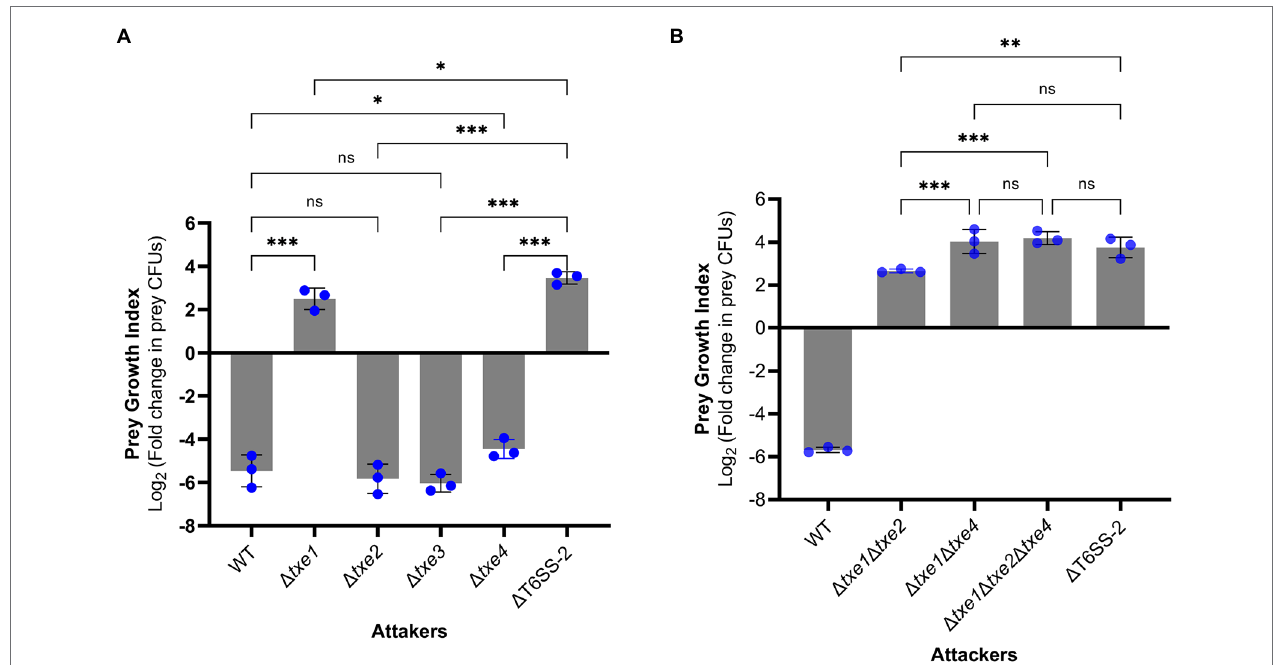
FIGURE 6 | Interbacterial competition assay with P. plecoglossicida wild-type (WT) and deletion mutants as attackers. The prey growth index (PGI) was calculated from the prey strain E. coli XL10 when cocultured with P. plecoglossicida T6SS effector mutants or wild-type strain for 4 h. The PGI was defined as log2 fold change in prey CFUs (ratio of 4–0 h). A higher PGI indicates a lower ability of the attacker strain to kill the prey strain. PGI of single-effector deletion mutants vs. WT strain and Δ T6SS-2 (A) . PGI of a triple-effector deletion mutant vs. WT strain and Δ T6SS-2 (B) . Bars show mean ± SD of three biological replicates, with individual data points superimposed. Each data point represents the mean value of three technical replicates. The experiment was repeated twice with similar results, and the results from a representative experiment are shown. Comparison of PGI values between groups was performed using a one-way ANOVA and Fisher’s LSD test. ns, not significant ( p > 0.05, * p ≤ 0.05, ** p < 0.001, *** p < 0.001, and Student’s t